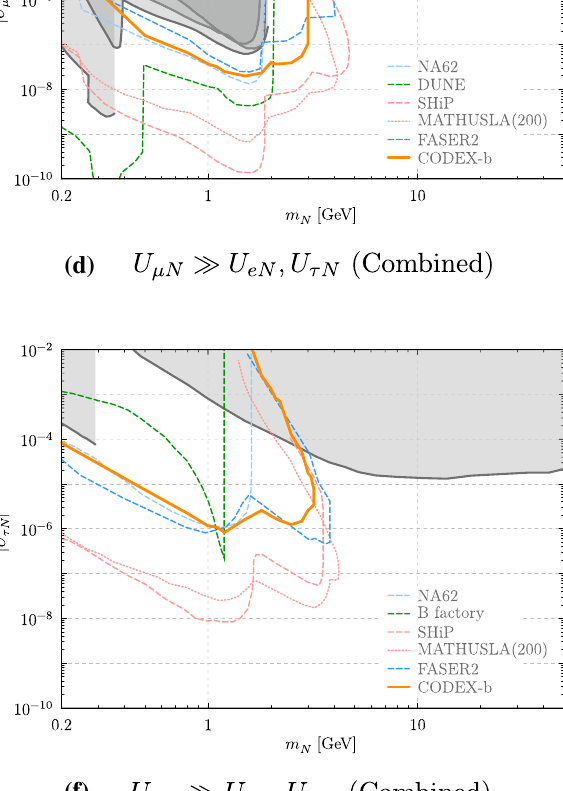
for its 200 m × 200 m configuration. ATLAS [100] and CMS